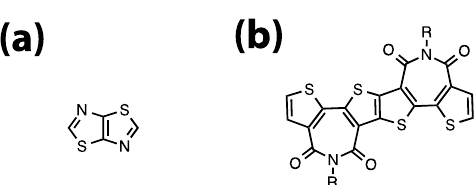
Figure 1. Molecular structure of ( a ) thiazolothiazole (TzTz) and ( b ) dithienothienothiophenebisimide (TBI).